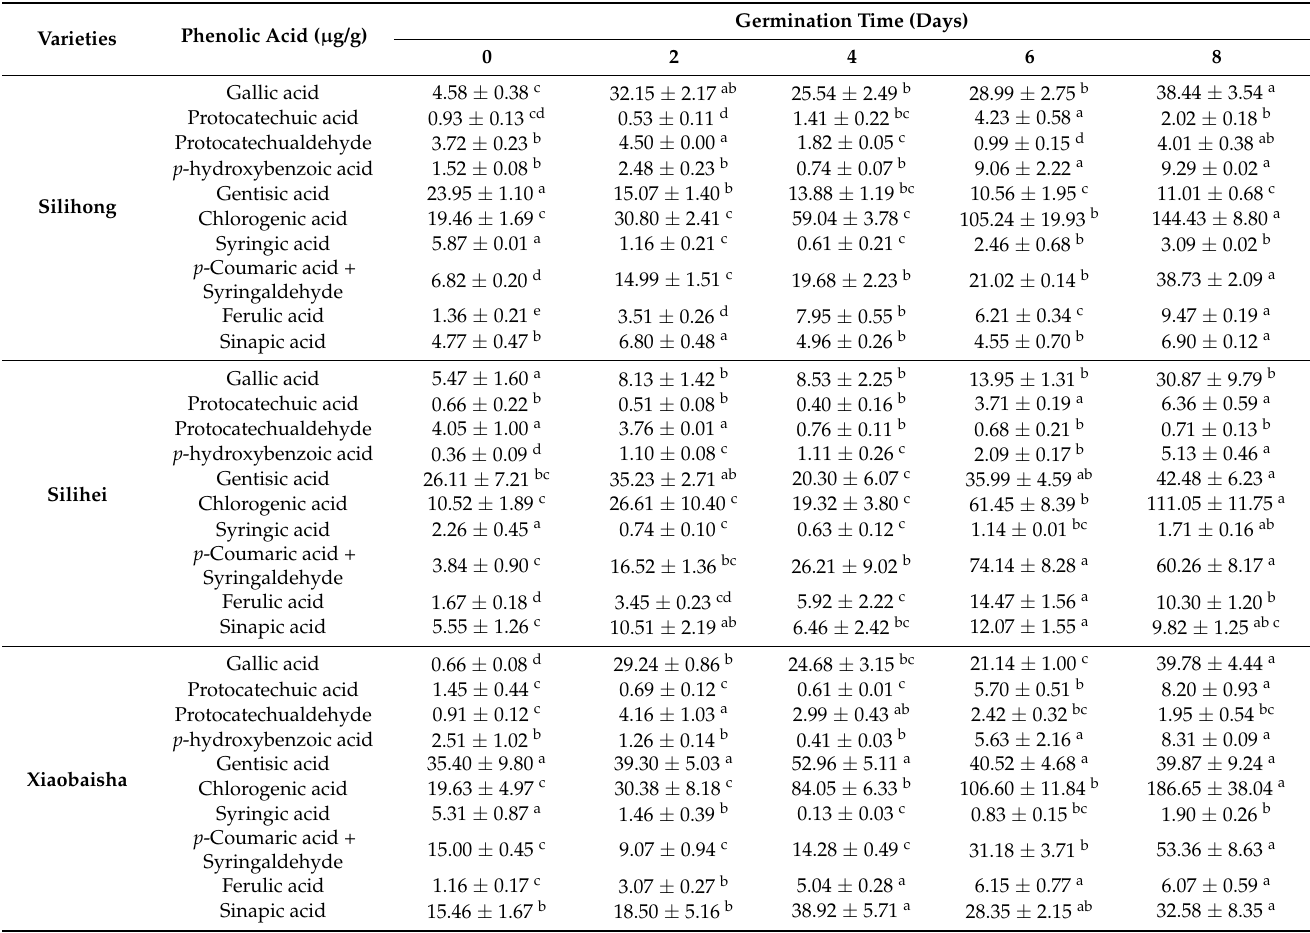
Table 2. Phenolic acid profile of different peanut samples during